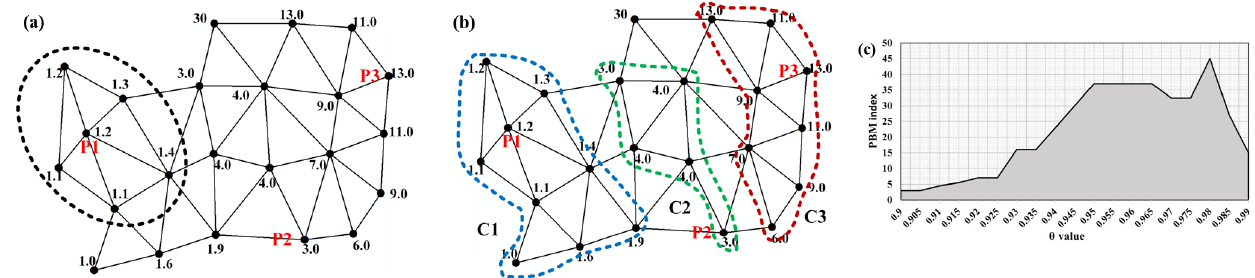
Figure 5. Attribute clustering based on the modified method: ( a ) simulated data with attribute; ( b ) spatial clustering regarding attribute similarity; ( c ) curve graph of 𝜃 score and the index of PBM.